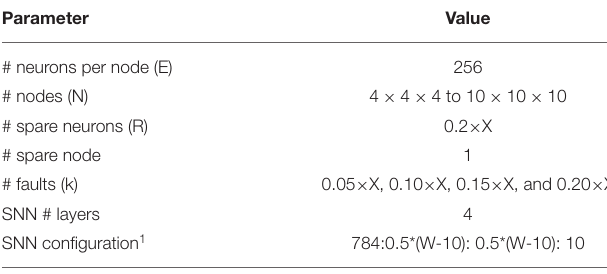
TABLE 1 | Configuration for the mapping evaluation 1